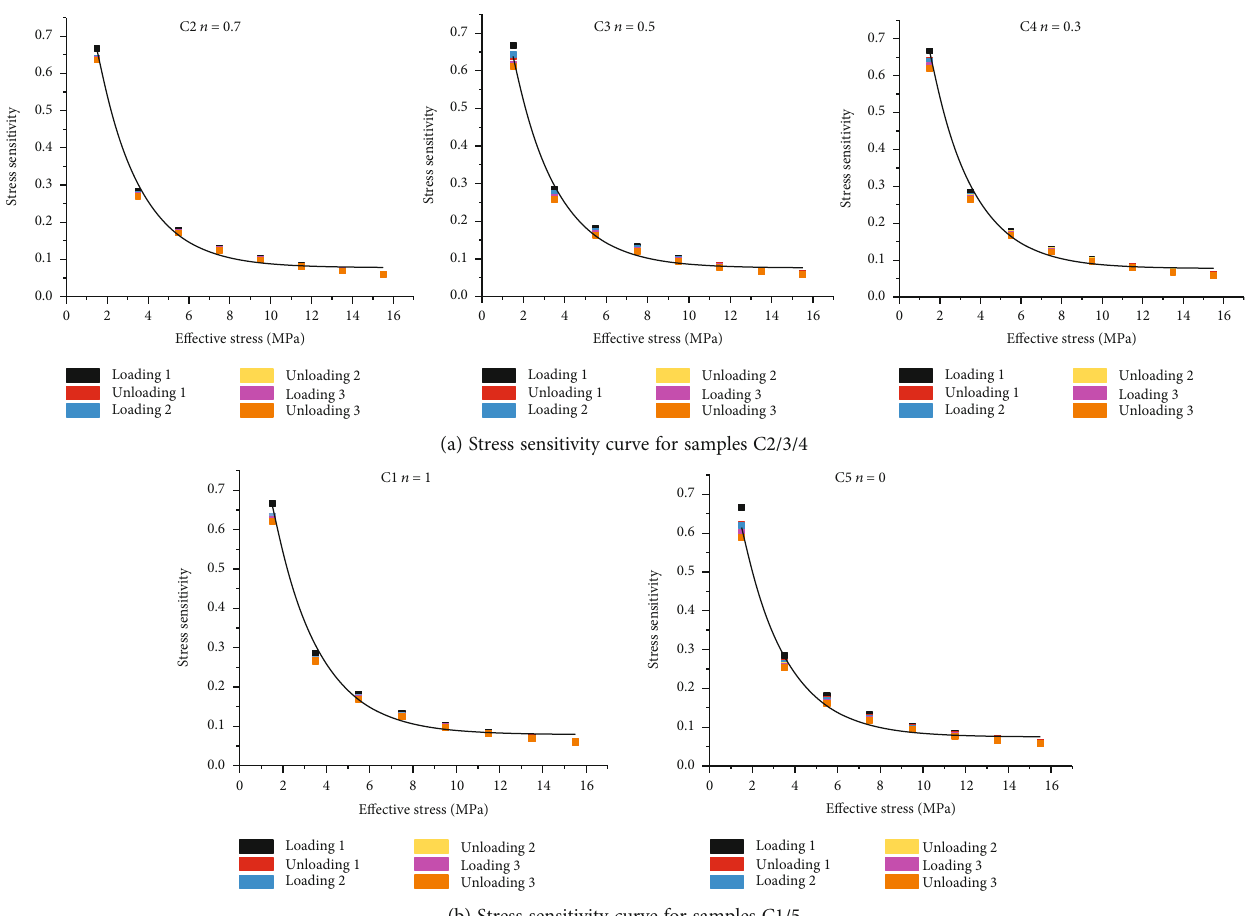
Figure 13: Stress sensitivity curve for samples C1 to